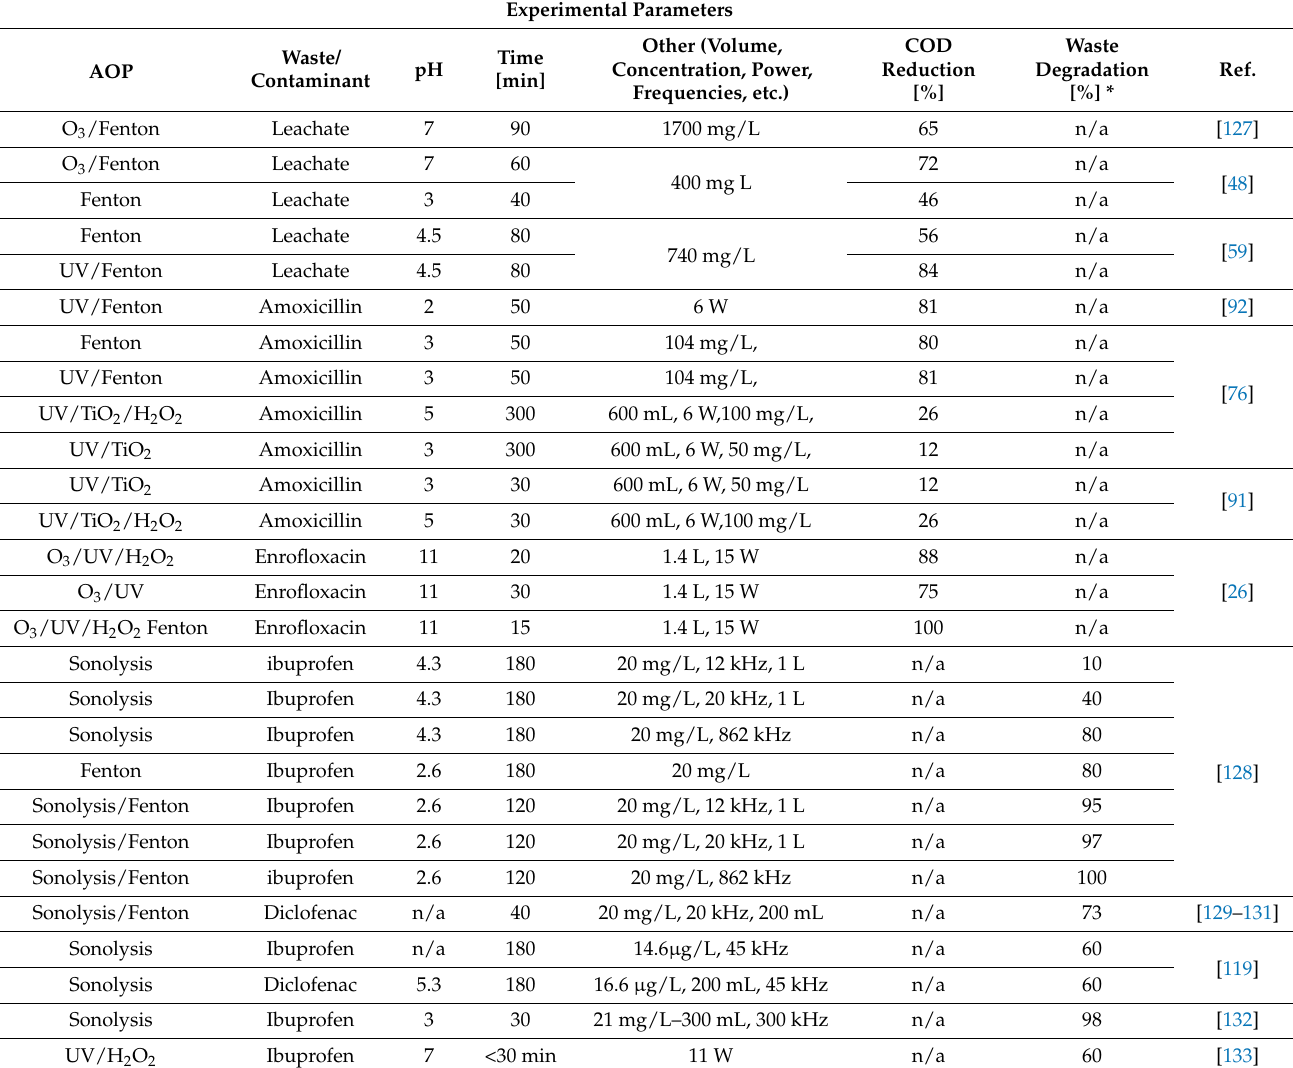
Table 2. Comparison of AOP degradation efficiencies in leachates and antibiotic effluents. Experimental